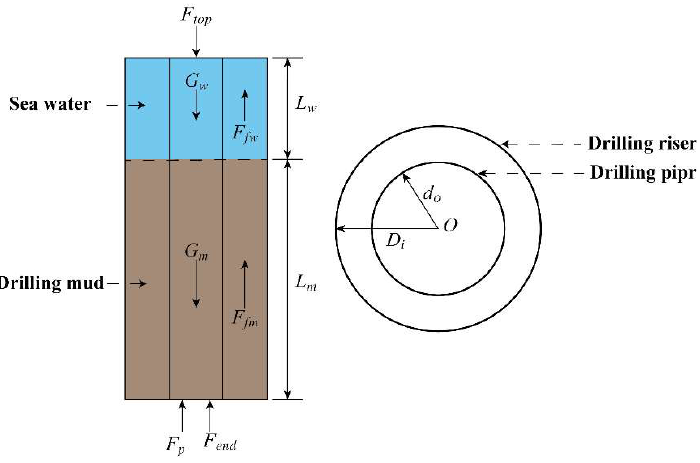
Figure 4. Mechanical model of the mud discharge [37].